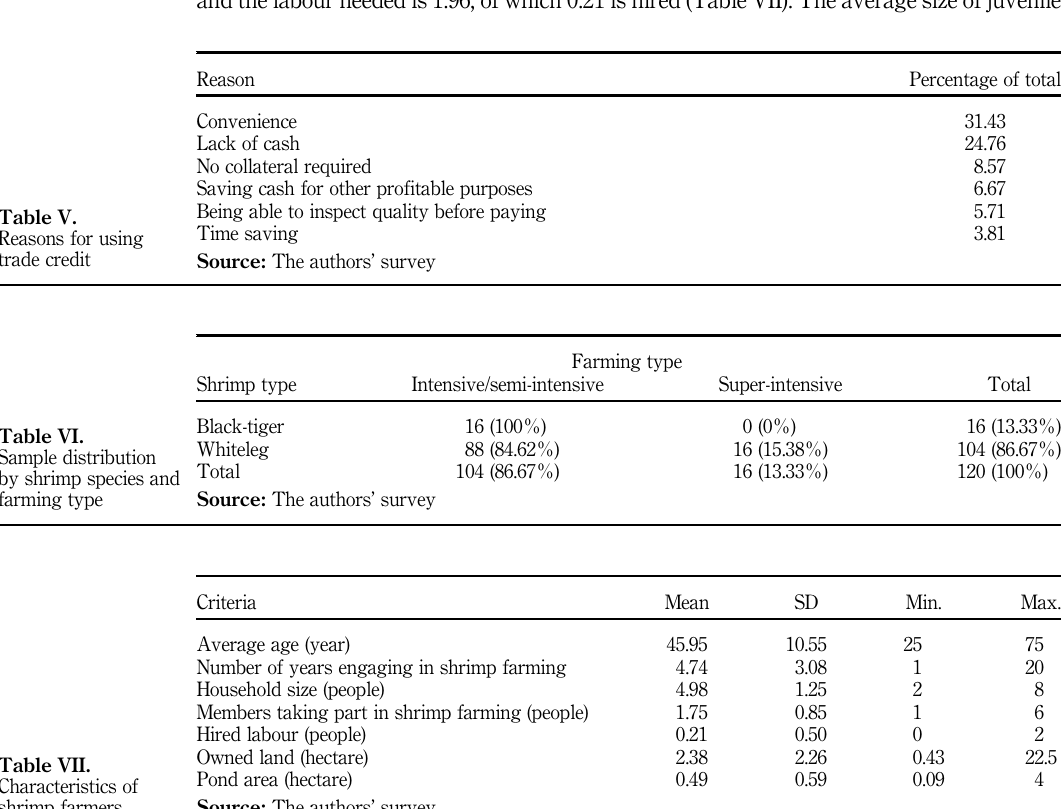
Table VII. Characteristics of shrimp